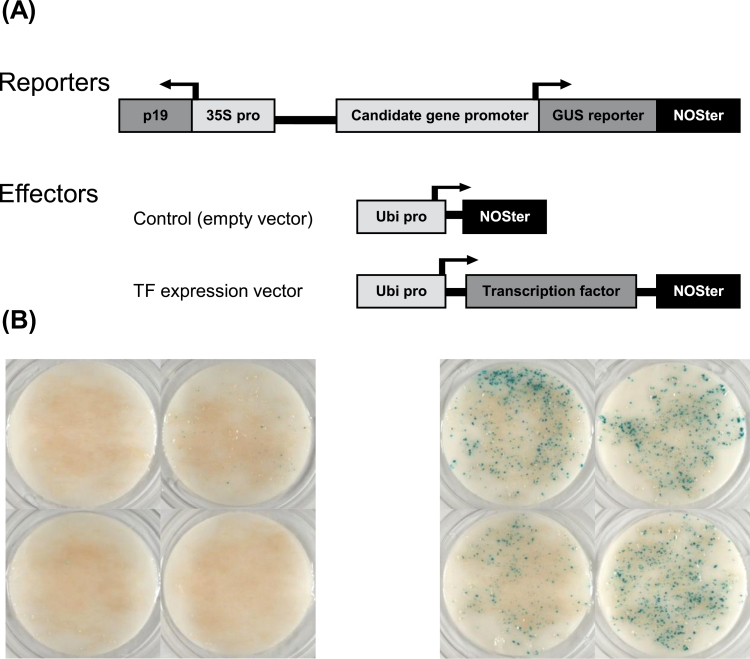
Overview of the components of the trans-activation method. (A) Schematic diagrams of the effector and reporter plasmids. The reporter constructs consisted of a GUS reporter gene driven by the tested candidate gene promoter; p19 driven by the CaMV 35S promoter was inserted into the same plasmid. The effector constructs consisted of the Gateway-inserted complete coding sequence of each TF driven by the maize ubiquitin promoter. The control (empty vector) consisted of the expression vector without TF insertion. (B) Representative positive trans-activation. Histochemical GUS assay was performed after 6 d of embryogenic cells/agrobacteria coculture. Left: control assay of white spruce cells transformed with the PgMYB8 promoter-reporter construct and empty vector effector construct; right: white spruce cells transformed with the PgMYB8 promoter-reporter construct and the PgNAM-7 effector construct.